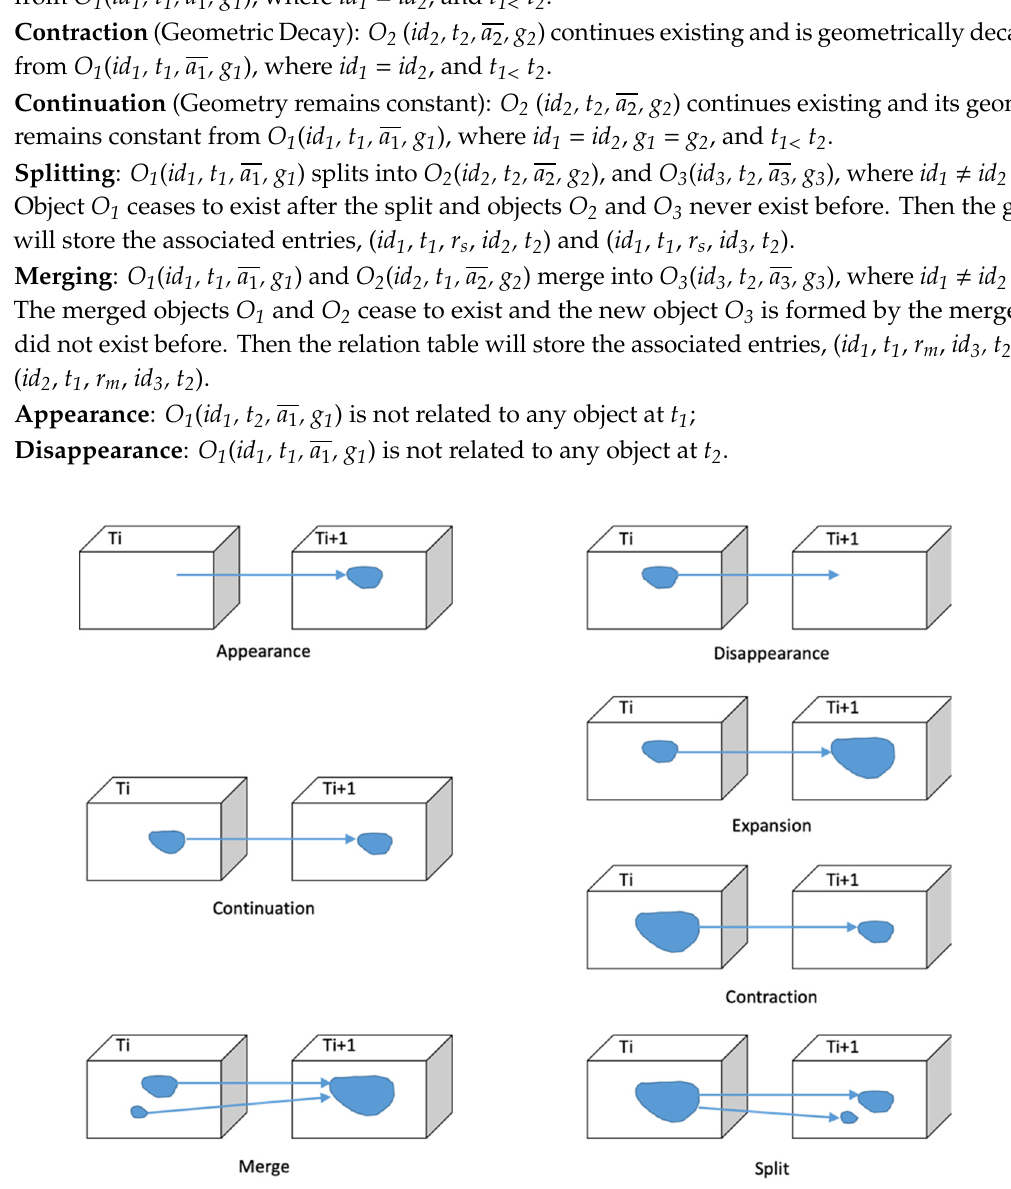
Figure 2. ST-relations between objects at t i and t i+1 .